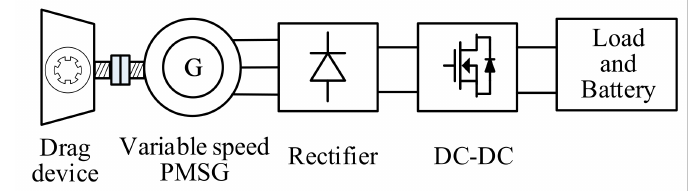
Figure 1. PMSG power supply